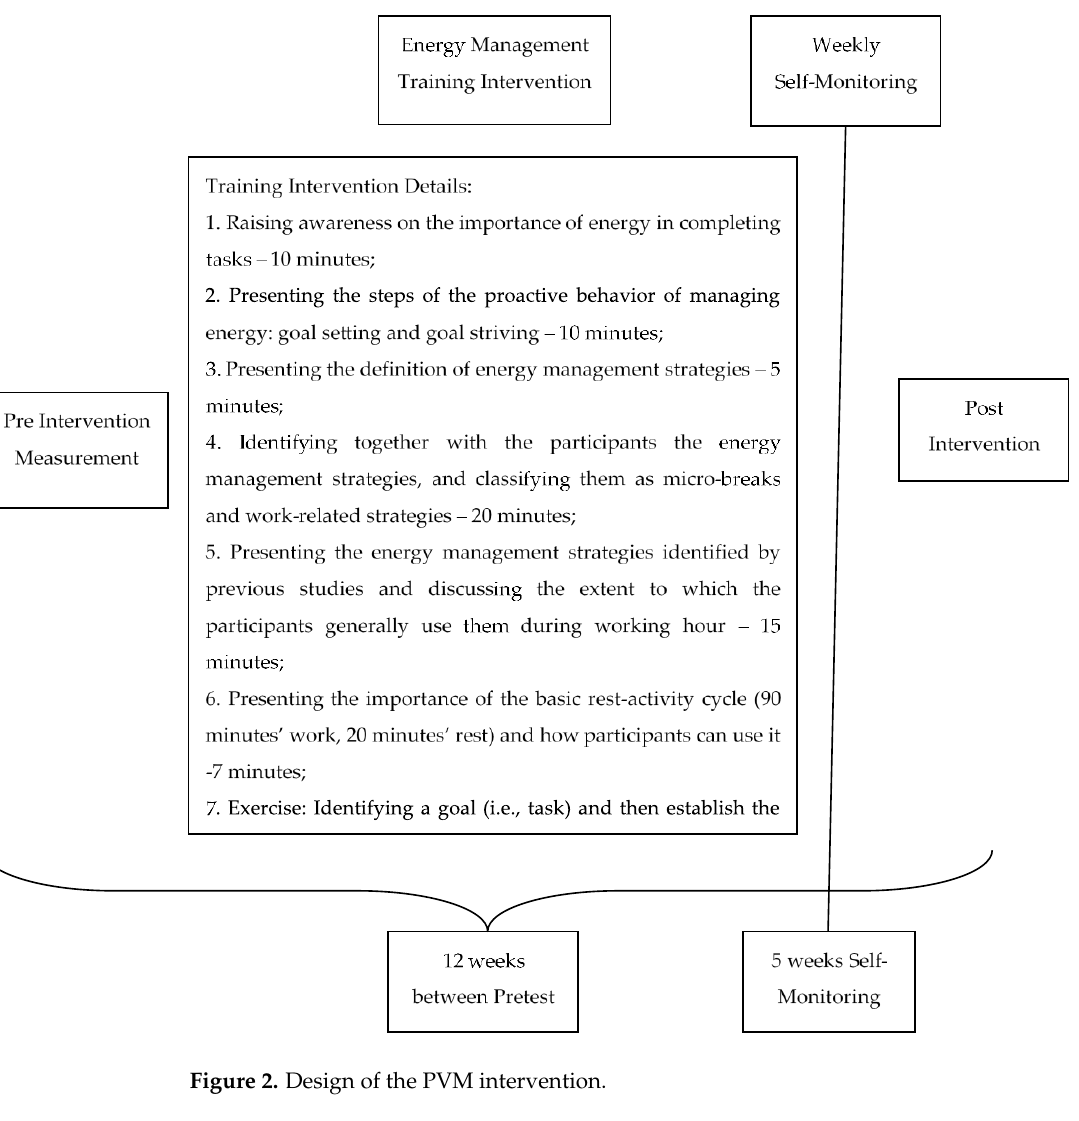
Figure 2. Design of the PVM intervention .